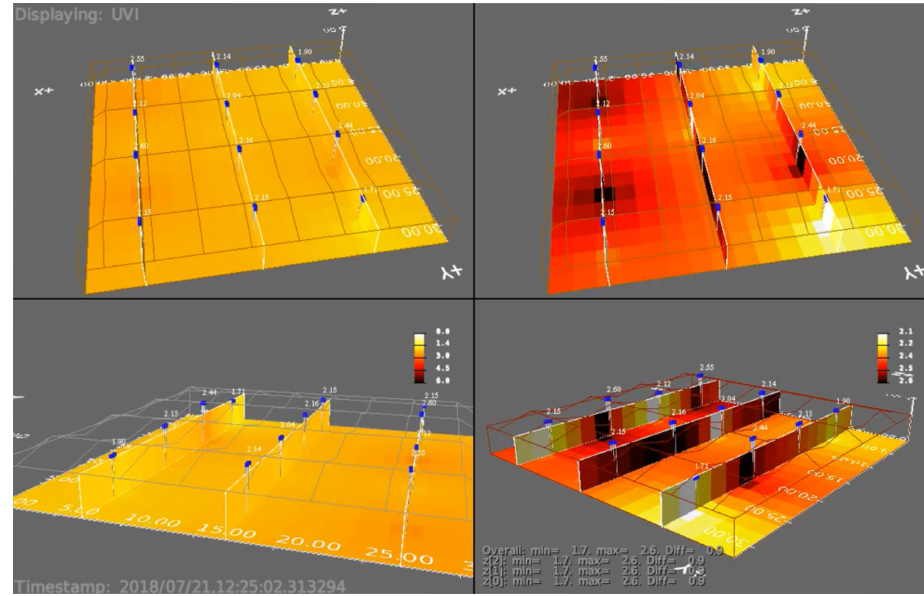
Figure 6. Image capture of the 3D video of the UVI measurements inside the greenhouse at 12:25 a.m., 21st July